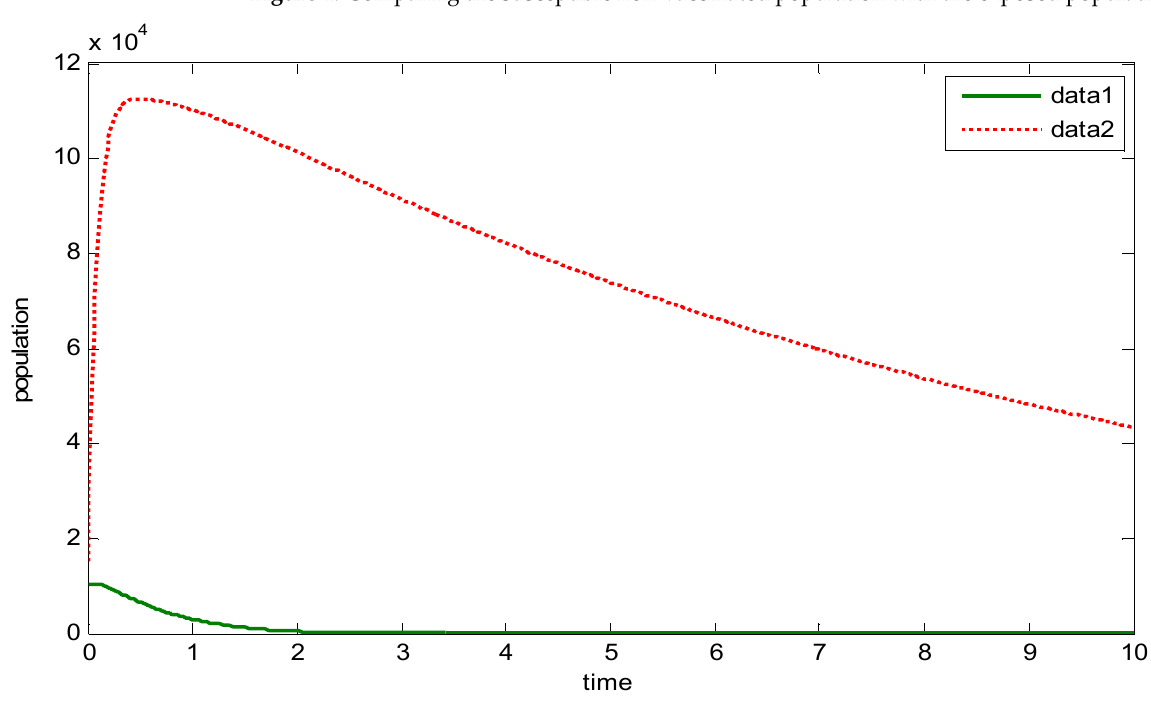
Figure 4. Comparing the susceptible non-vaccinated population with the exposed population.